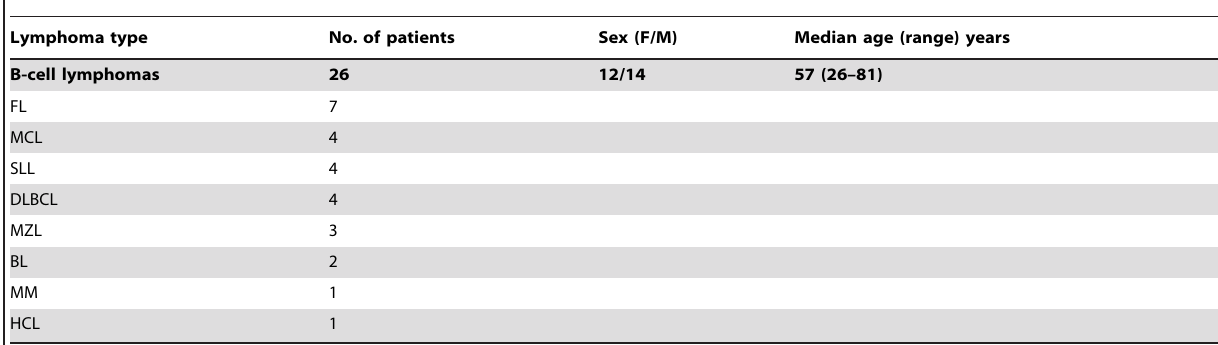
FL — follicular lymphoma; MCL — mantle cell lymphoma;SLL — small lymphocytic lymphoma; DLBCL — diffuse large B-cell lymphoma; MZL — marginal zone lymphoma; BL — Burkitt lymphoma;MM — multiple myeloma; HCL — hairy cell